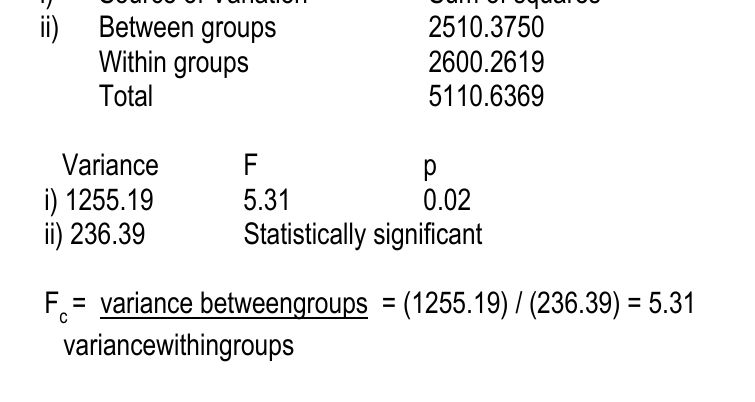
Table 5. ANOVA Test for Physics Lab Courses Course Variable PHE03(L) PHE08(L) PHE12(L) Mean pass percentage 65.5 71.8 97.7 σ 20.23 15.37 2.47 N